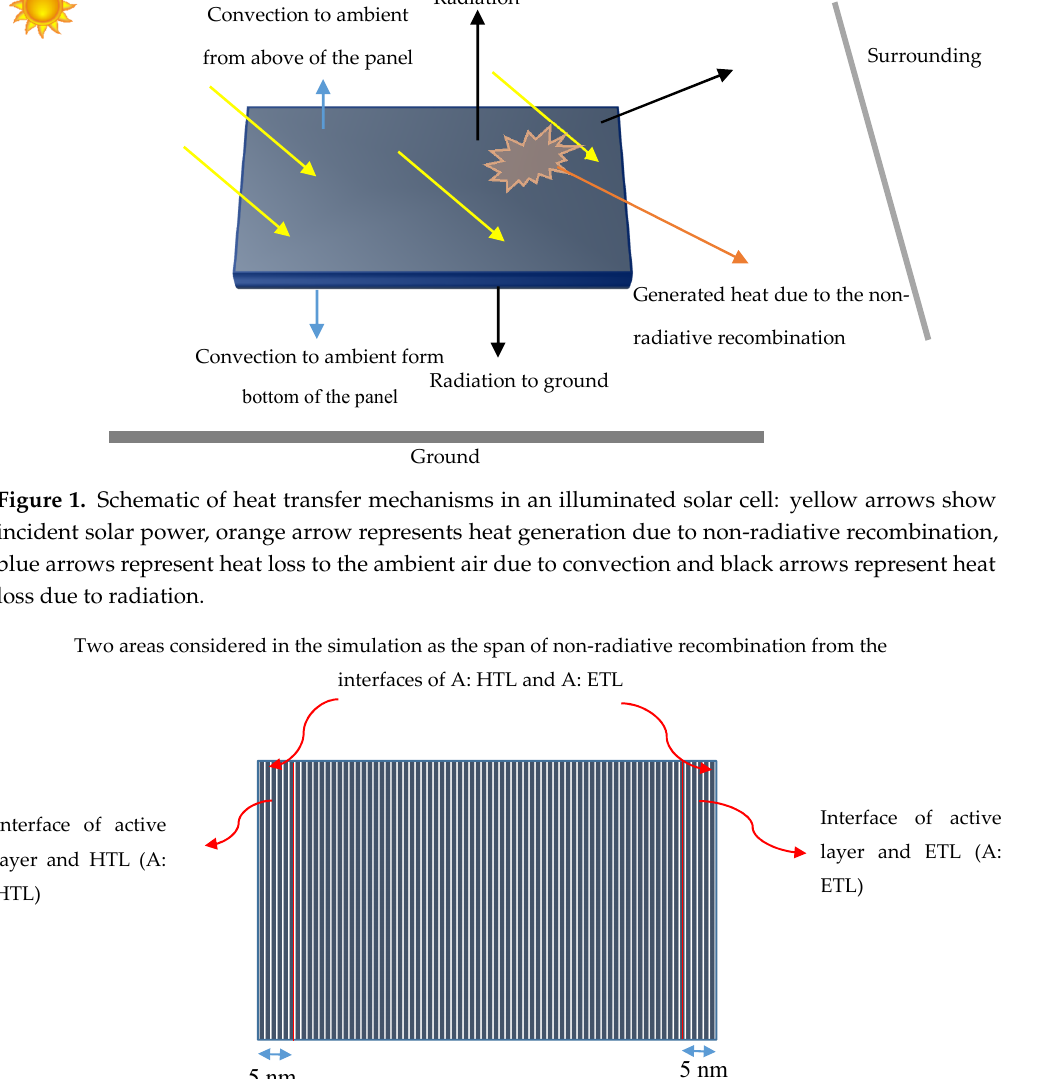
Figure 2. Division of the active layer of a PSC into meshes considered in the simulation. A distance of 5 nm from A: hole transport layer (HTL) and A: electron transport layer (ETL) interfaces into the active layer has been considered as the main areas of non-radiative recombination.